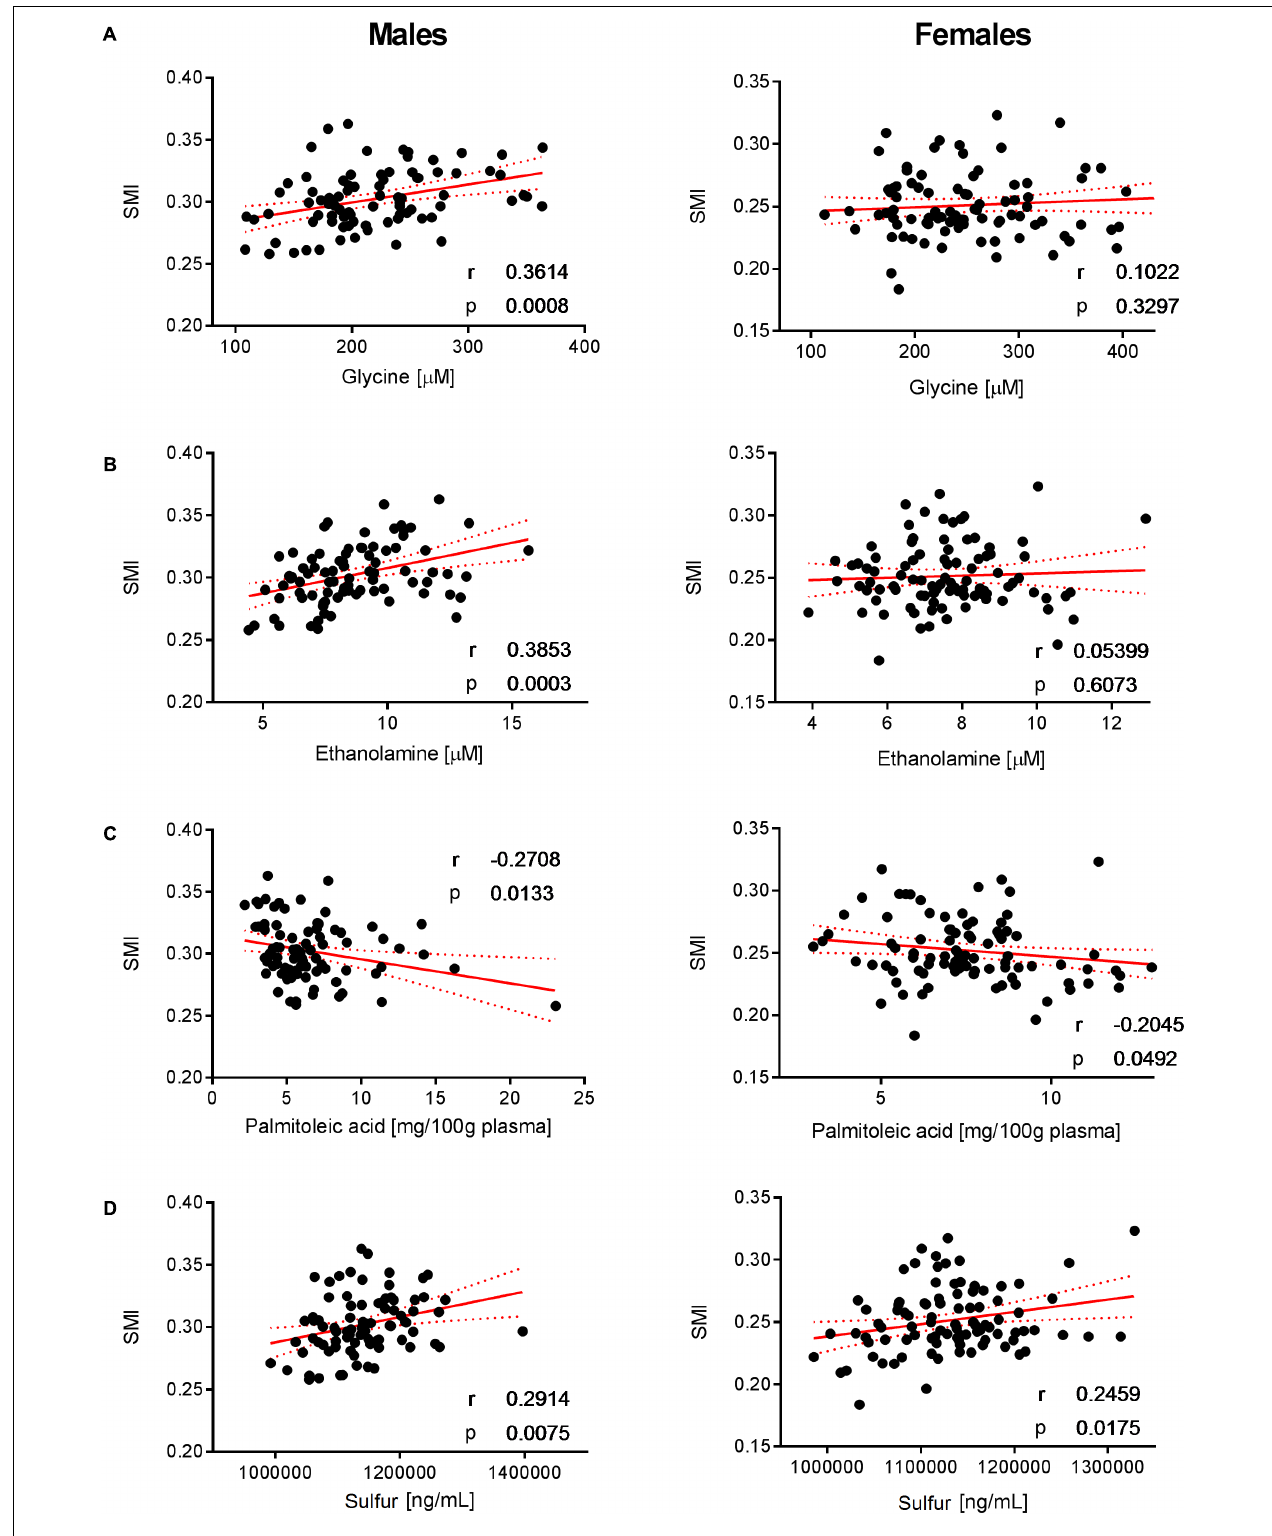
FIGURE 5 | Correlation of glycine, ethanolamine, palmitoleic acid, and SMI. Significant correlations of (A) glycine, (B) ethanolamine, (C) palmitoleic acid, and (D) sulfur with SMI were observed in males but not in females. Pearson’s correlations (r) as well as two-tailed p -values are shown. N = 83 (males) and N = 93 (females). Each dot represents an individual sample. Red dotted lines show 95% confidence interval.